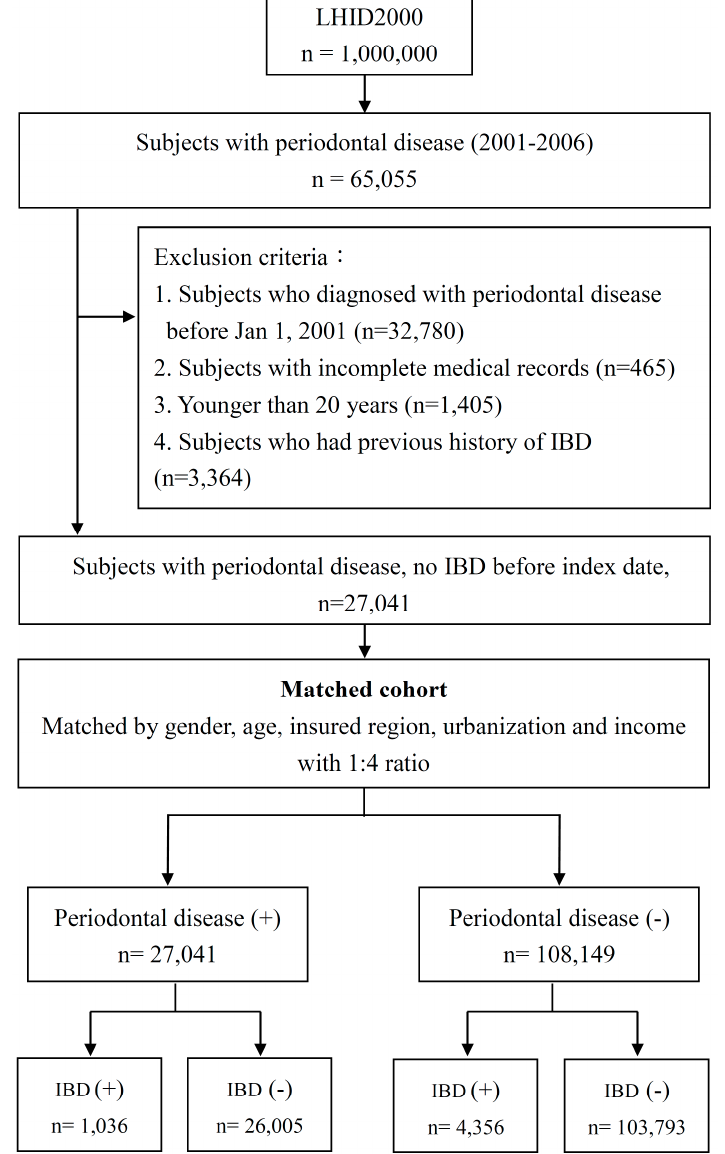
Figure 1. The flow chart for enrollment of study cohorts. LHID: Longitudinal Health Insurance Database; IBD: inflammatory bowel disease.